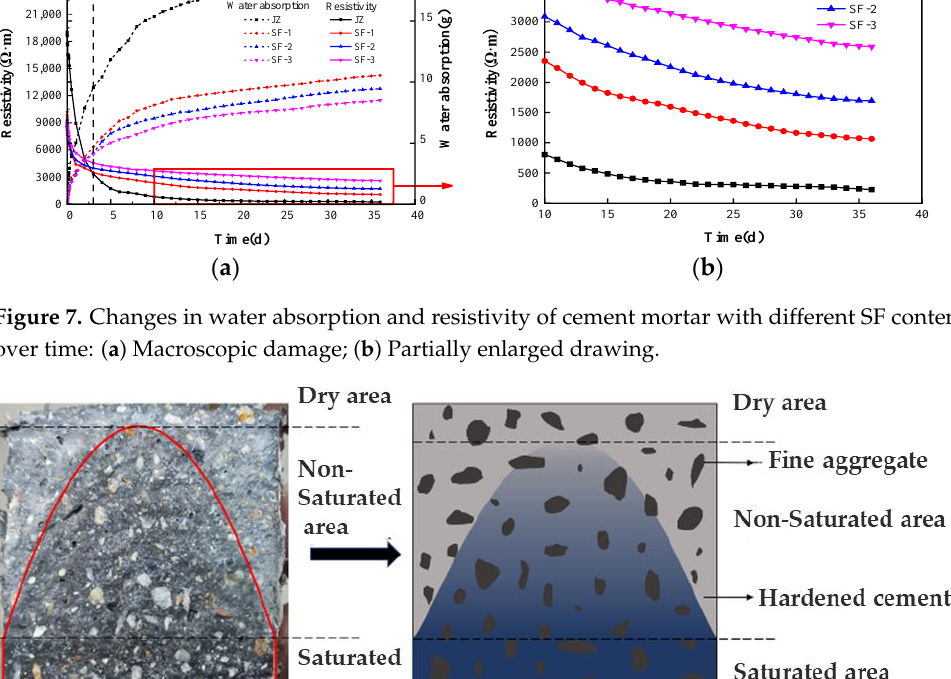
Figure 8. The capillary water distribution in the section of 1/2 length of the specimen (after 36 days of capillary water absorption). Figure 9. Diagram of a cement mortar opening pore: ( a ) Opening pore structure under dry condi- tions. ( b ) Opening pore structure under capillary water absorption.